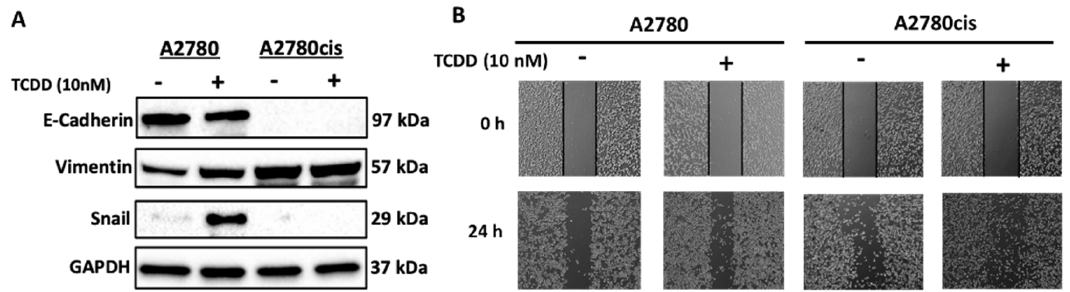
Figure 5. Effect of AhR activation on EMT levels and metastasis potential in A2780 and A2780cis cells. A2780 and A2780cis cells were treated for 24 h with 10 nM TCDD. ( A ) Protein expression levels of E − cadherin, vimentin, and snail were determined by Western blot analysis. The protein panels are a composite of different blots and are representative blots for the indicated proteins and the loading control. ( B ) Migratory behavior was performed using a wound − healing assay. The semi − quantitative analysis of the expression of the target proteins is presented in Figure S2.